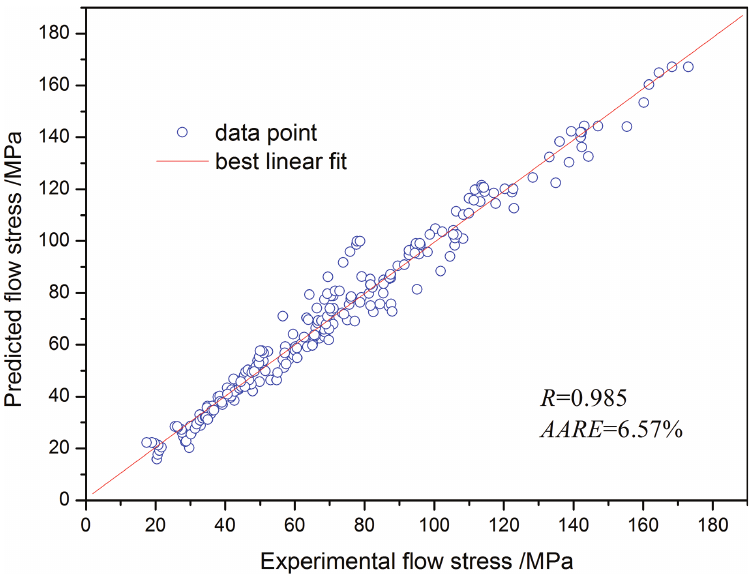
Figure 17: Correlation between the experimental and predicted flow stress data from the M-JC constitutive